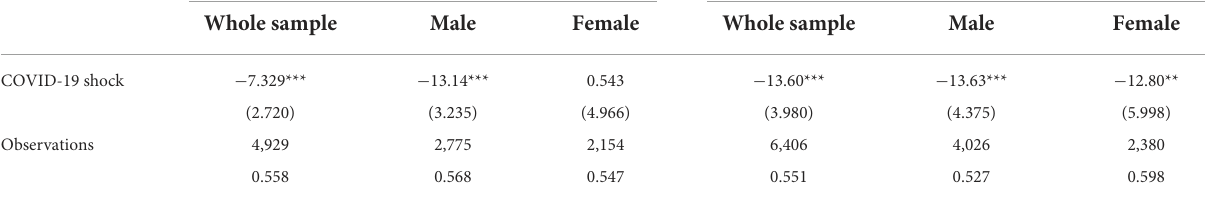
TABLE 13 Impact of telecommuting